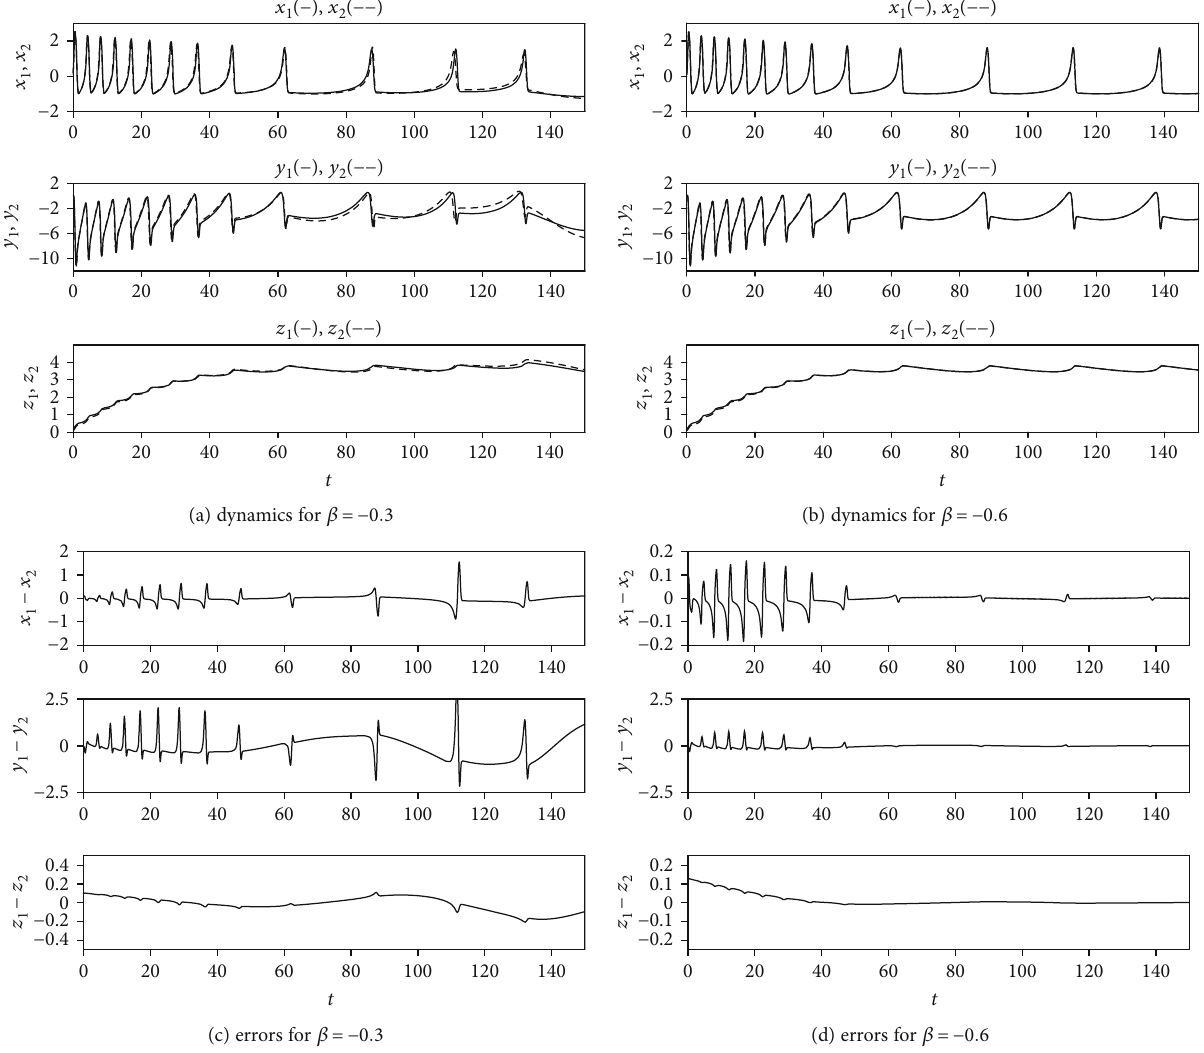
Figure 1: The dynamics of system (2) with r = 0 : 02 and I = 3 : 6 : (a) β = − 0 : 3 and (b) β = − 0 : 6 . Synchronization errors: (c) β = − 0 : 3 and (d) β = − 0 : 6 . The initial conditions are x